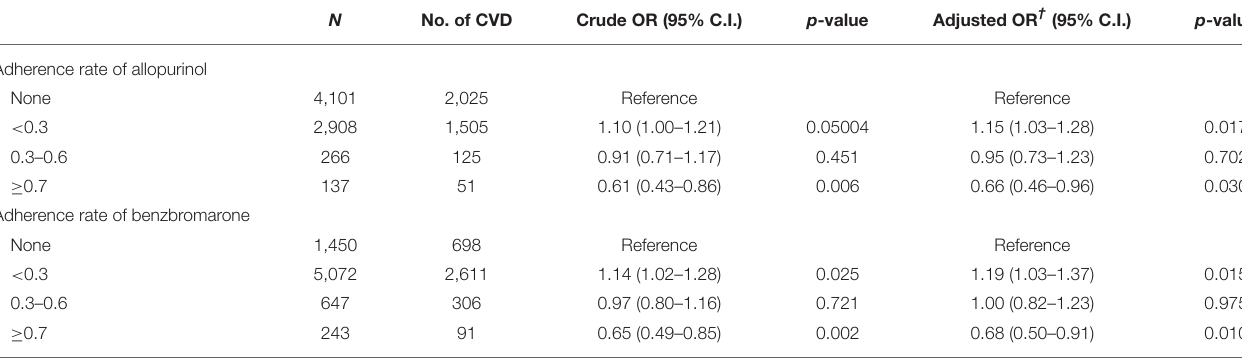
TABLE 3 | Logistic regression of risk of CVD divided by adherence rate of allopurinol and benzbromarone. N No. of CVD Crude OR (95% C.I.) p -value Adjusted OR † (95% C.I.) p -value Adherence rate of